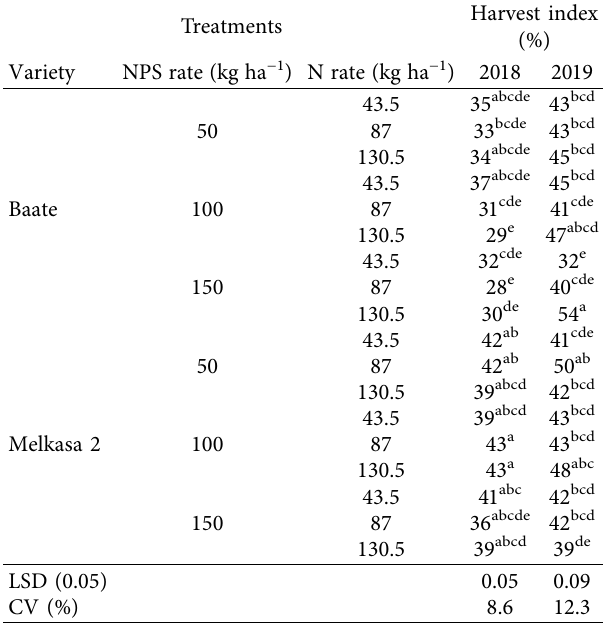
Table 11: Harvest index as affected by three-way interaction of variety, NPS, and N in both seasons.